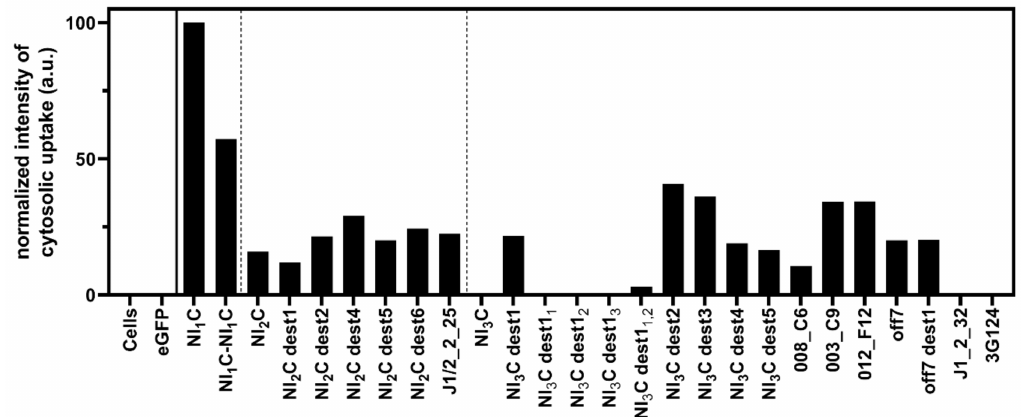
Figure 1. Quantification of Western blots shown in Supplementary Figure S1, measuring the delivery of different LF N -cargo constructs with PA wt -sANTXR-Ac2 from a representative experiment. Cargo proteins delivered to the cytosol become biotinylated by cytoplasmic BirA and are subsequently stained with Streptavidin IRDye 680LT. Cytosolic uptake was determined by normalizing signal intensities of cytosolic uptake to the signal of the unspecific interaction of streptavidin with HSP70, which correlates well with the actin signal, and thus can serve as an intrinsic calibration [6]. The delivered cargo DARPin with one internal repeat (labeled “NI 1 C”) is used as a control for maximum signal intensity of cytosolic uptake and cells without any delivered cargo (labeled “Cells”) as a negative control. The location of the mutations in the destabilized (dest) DARPins is listed in Table 1, Figure S3b, and